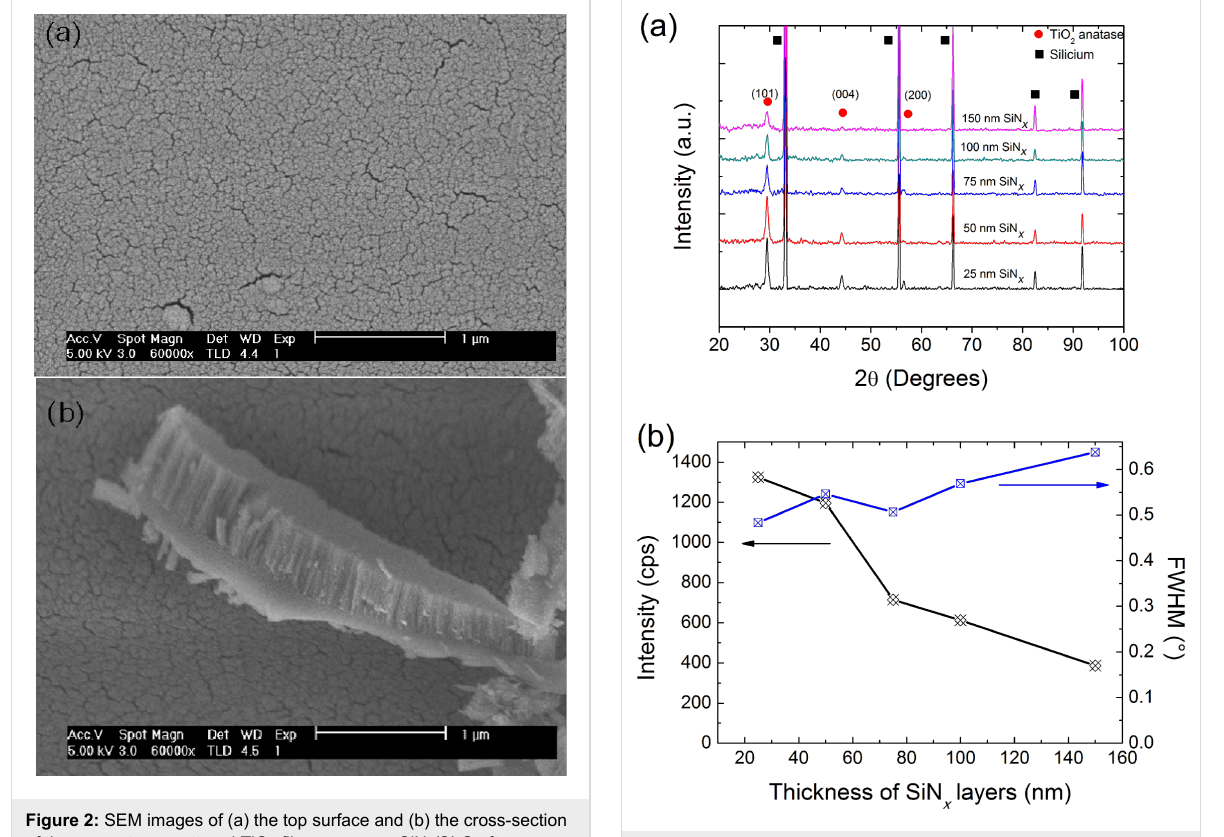
Figure 3: (a) XRD patterns and (b) FWHM and the intensity of the (101) plane of the sol–gel TiO 2 coatings as a function of the SiN x layer